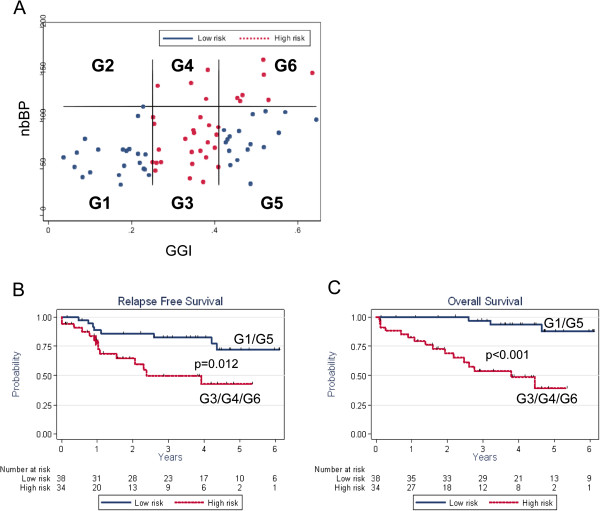
Genomic instability risk groups in stage 2 and 3 CRCs. Death and risk of relapse were correlated to genomic instability variables. A: Scatter plot integrating nbBP and GGI metrics. Three classes were determined for GGI:low (<0.25), intermediate ([0.25; 0.41[) and high (≥0.41) levels, with high risk associated to intermediate GGI, whereas two classes were defined for nbBP (<116 vs ≥116), with high risk being associated to high number of breakpoints. This produced 6 groups of risk of which one was empty. Tumors within high risk groups are shown as red dots, low risk as blue dots. B: Relapse free survival according to risk groups. C: Overall survival according to risk groups. Red curves correspond to the high risk, blue curves to low risk group.